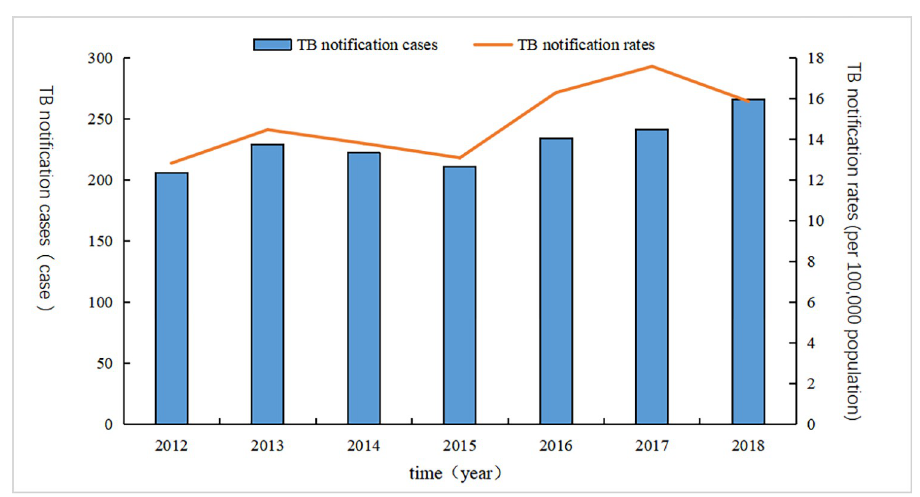
Fig 1. Reported incidence of pulmonary tuberculosis among students in Nanning, from 2012 to 2018.